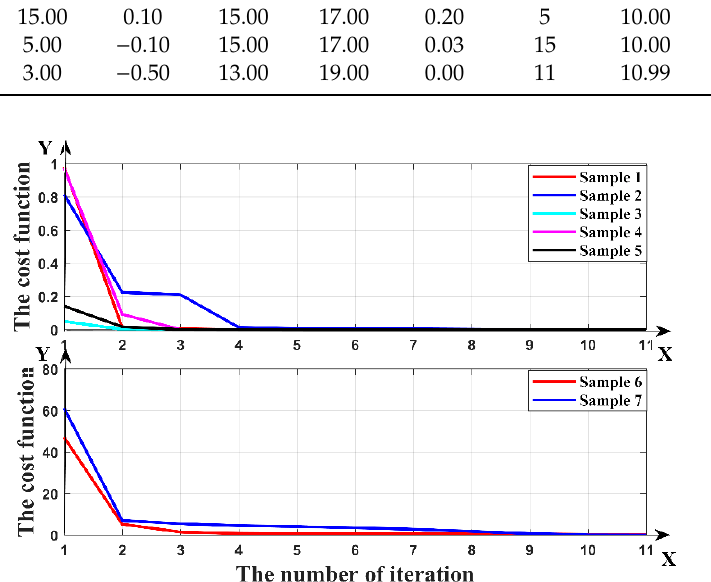
Figure 8. The cost function of the three-parameter inversion varying with the number of iterations.